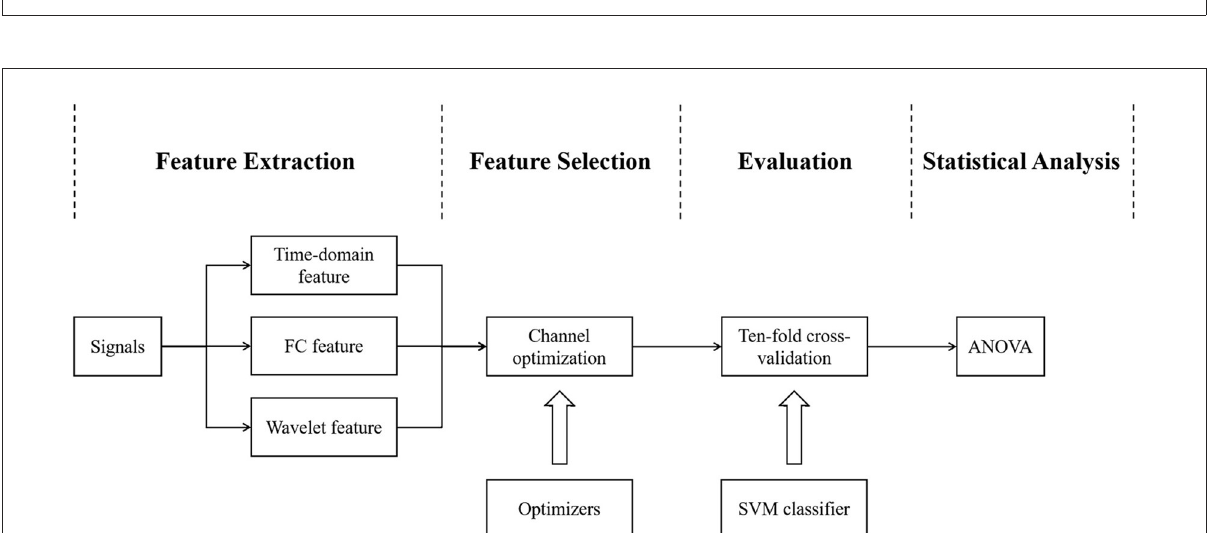
FIGURE3 Raw signals of a random HC and a random SZ in channel 19 for example.